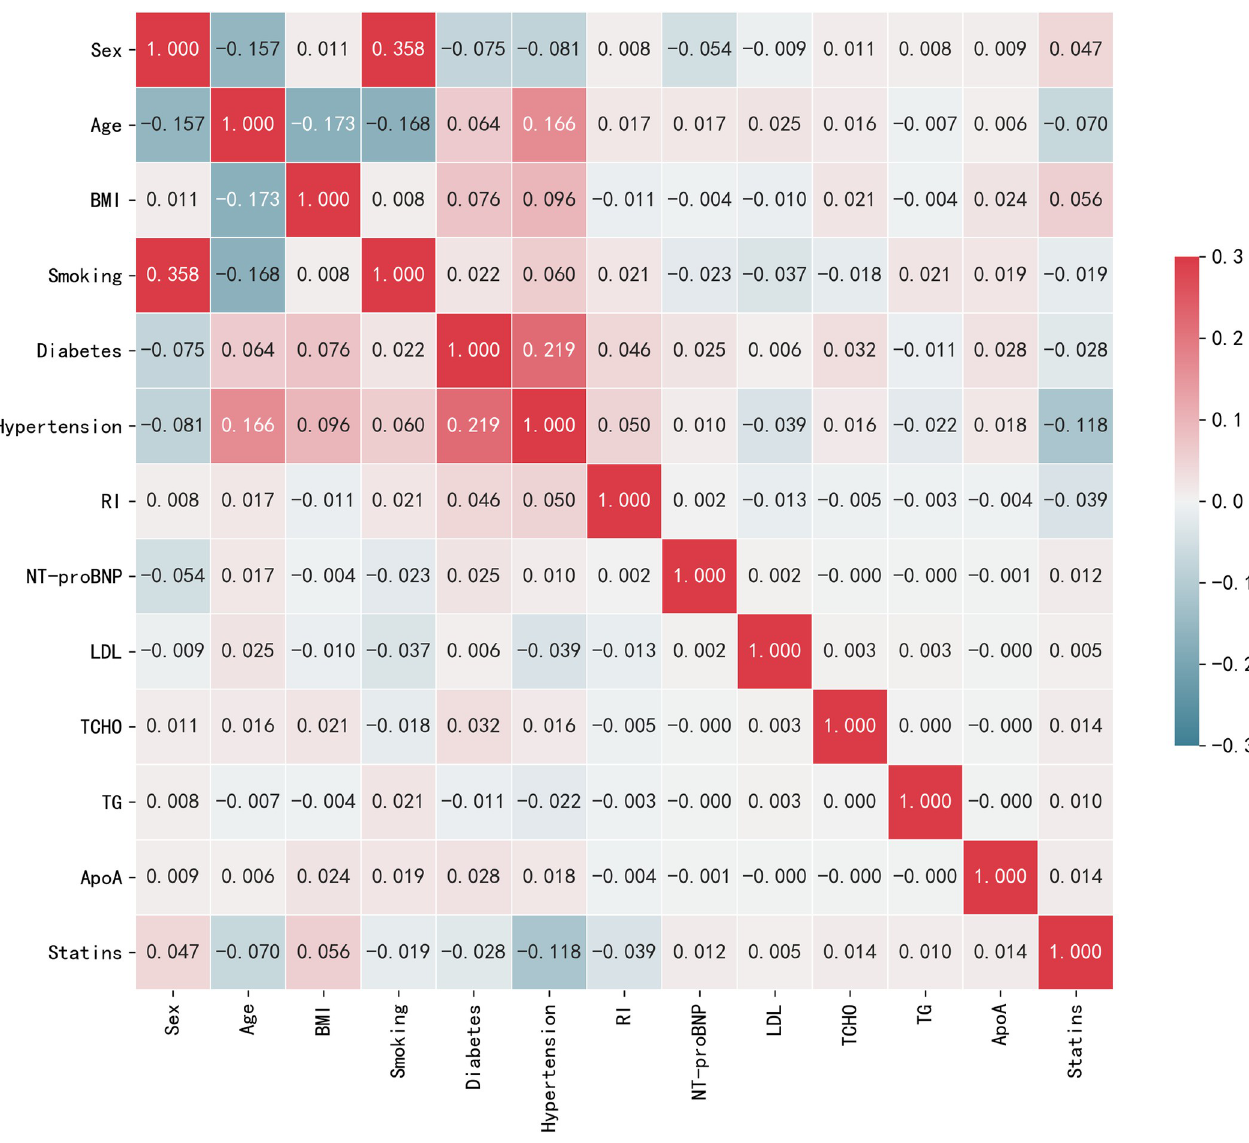
Fig 3. Interpretability of the correlation heatmap.